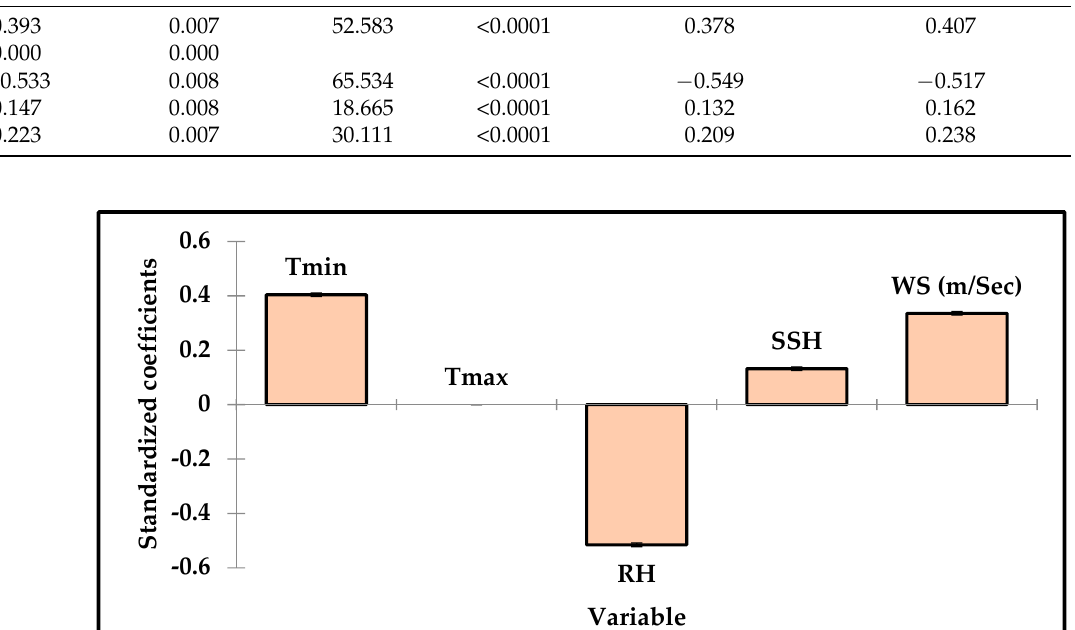
Figure 7. The standardized coefficients of input variable for sensitivity analysis at the New Delhi station for evaporation.